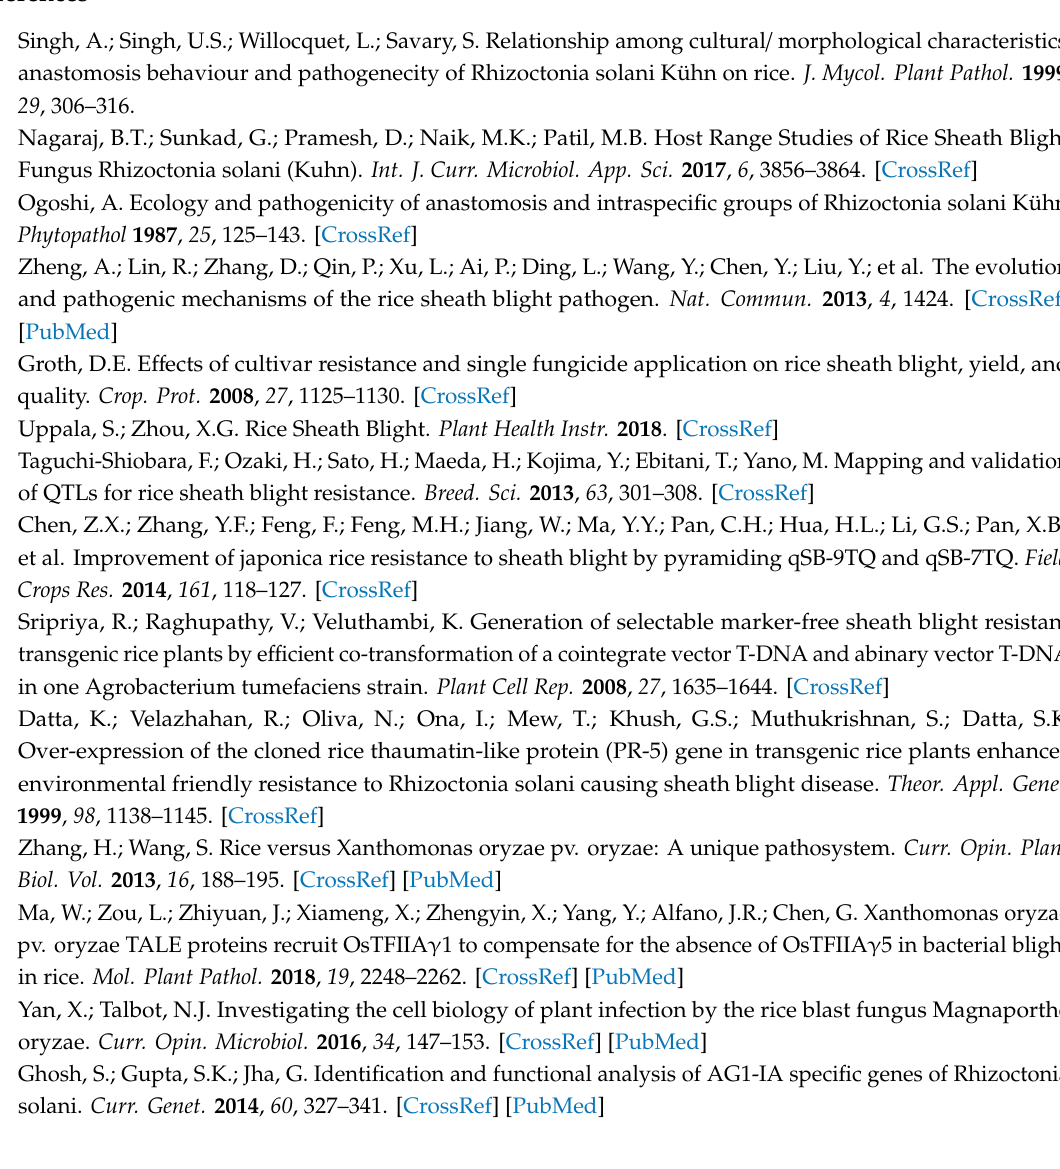
Table S3: The genes and their annotation showing cultivar specific expression, Table S4: Annotation of 14 genes involved in pectin